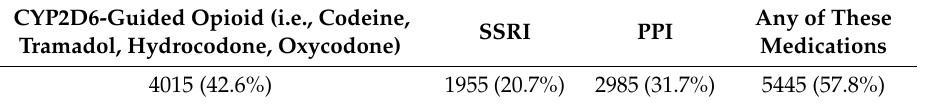
Table 2. Medication utilization at selected internal medicine site. 1.